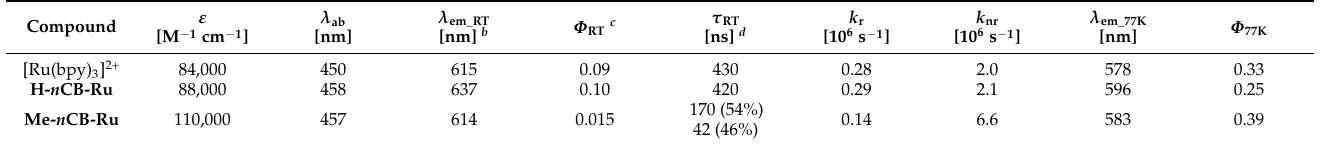
Table 1. Photophysical properties of the complexes a .